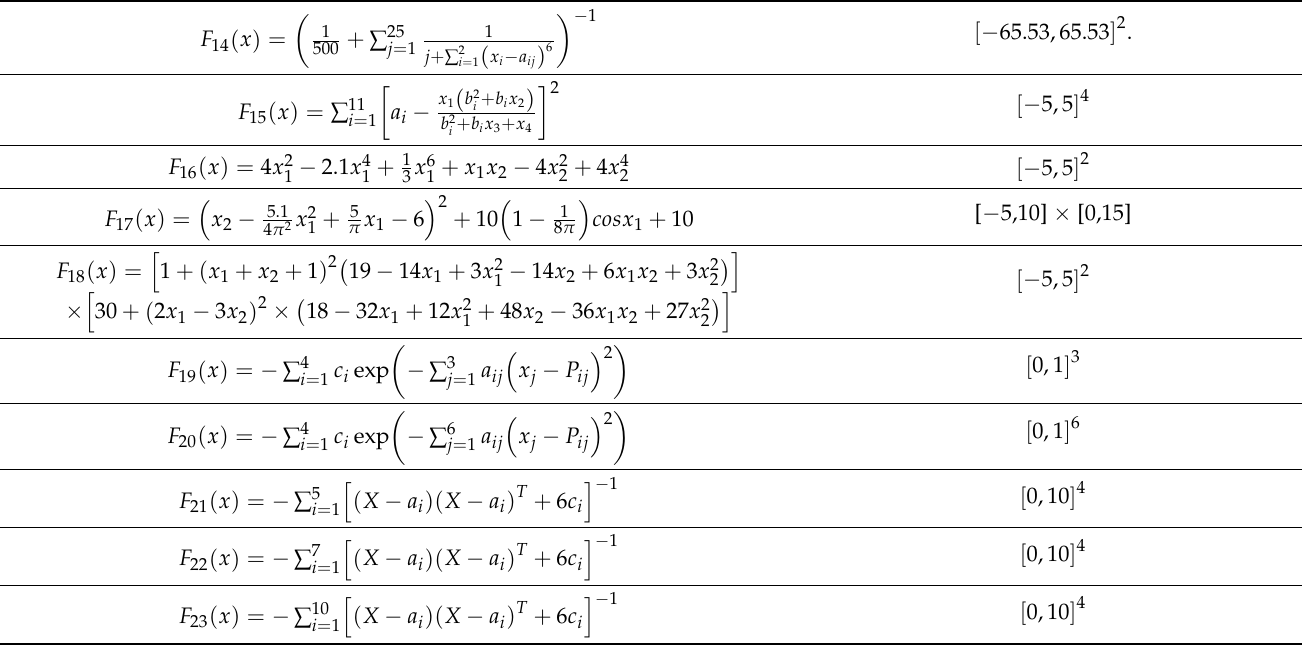
Table A3. Fixed-dimensional multimodal test